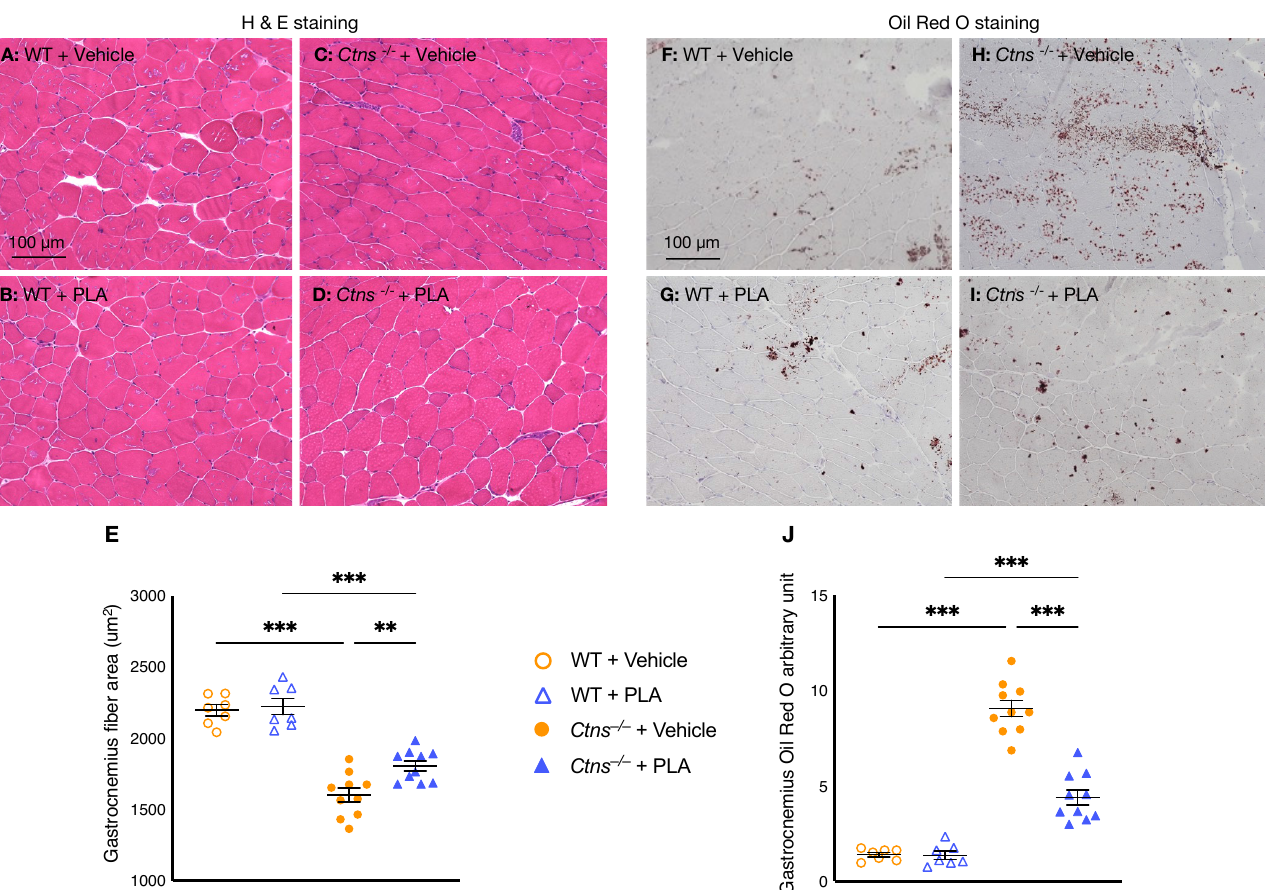
Figure 5. PLA increases muscle fiber size and attenuates muscle fat infiltration in Ctns − / − mice. Representative photomi- crographs of the gastrocnemius with H&E staining ( A – D ). Average gastrocnemius cross-sectional area was measured ( E ). Visualization of the quantification of fatty infiltration by Oil Red O analysis in the gastrocnemius muscle ( F – J ). Final results were expressed in arbitrary units, with one unit being the mean staining intensity in vehicle-treated WT mice. In addition, results of PLA-treated Ctns − / − mice were compared to vehicle-treated Ctns − / − mice and specific p -values are shown above the bar. ** p < 0.01, *** p < 0.001.